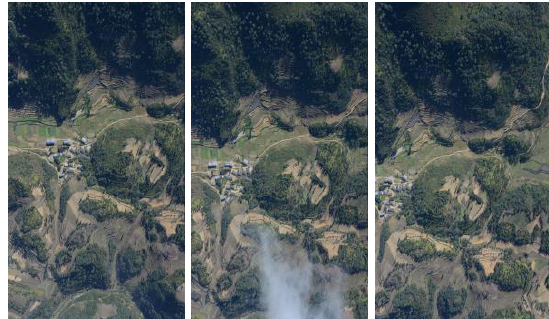
Figure 1. Adjoin remote sensing images